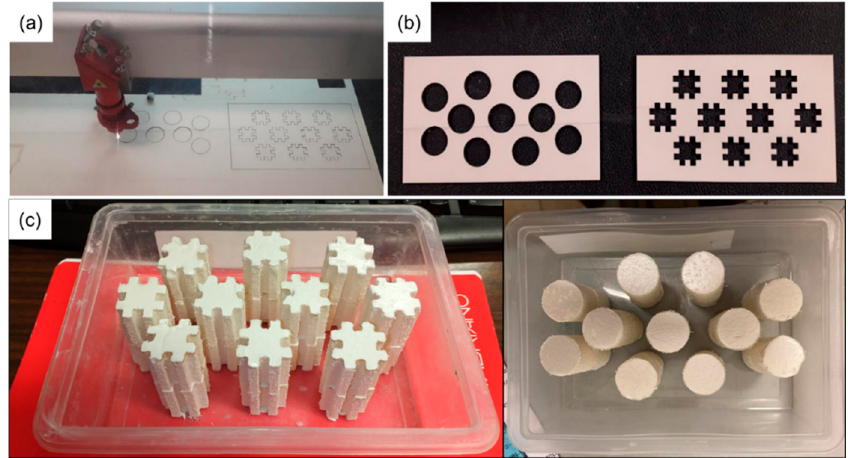
Figure 11. ( a ) Laser cutting of the guide-masks, ( b ) CHD and FHD guide masks, and ( c ) mold brick for FHD and CHD design.